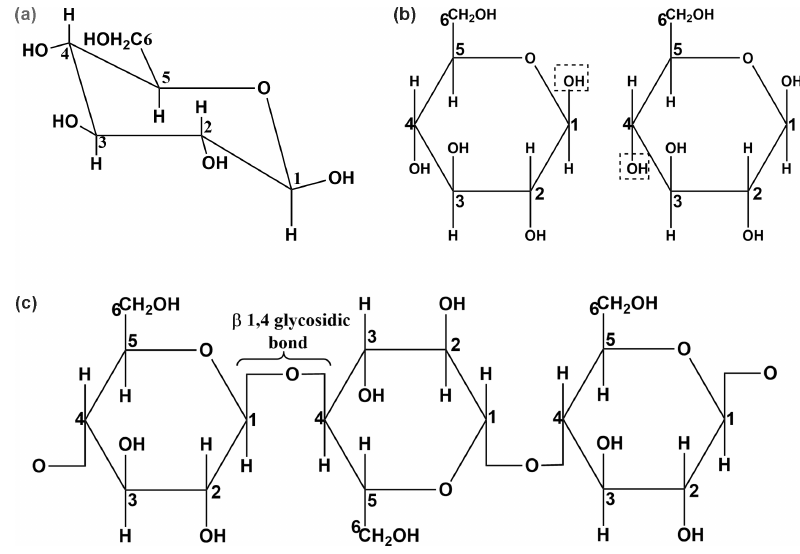
Figure 1. ( a ) Chair conformation of β -D-glucose. ( b ) Two OH groups (inside the dotted boxes) are far apart and do not form a covalent 1,4 glycosysdic bond. ( c ) Chemical structure of cellulose ( β -D-glucose in Haworth projection).